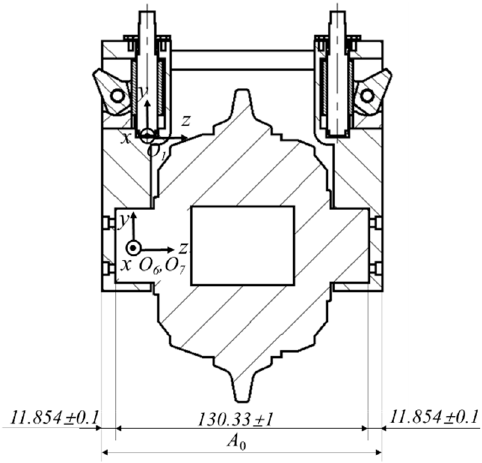
Figure 6. Local coordinates of cutter holder and disc